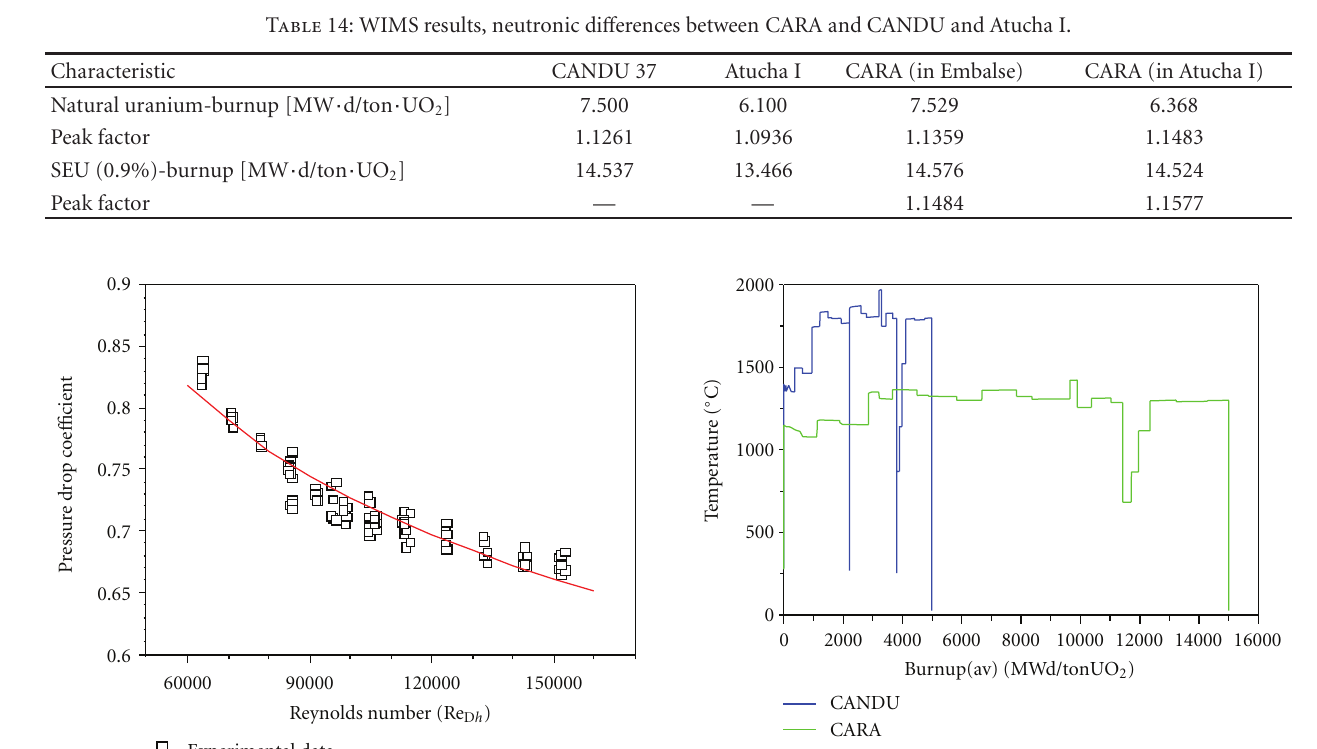
Figure 17: Averaged temperature at the pellet centre of a CANDU fuel rod CARA fuel.